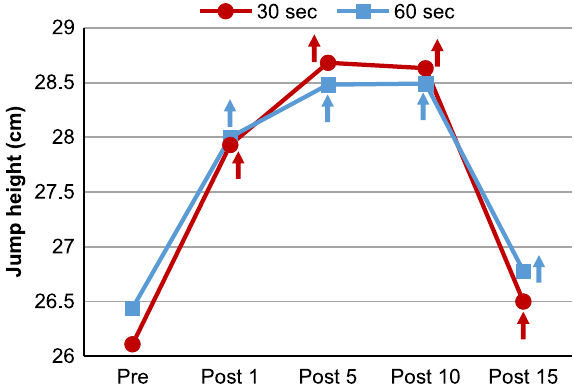
Figure 2. Squat jump performance for both protocols for the five assessments. Statistically significant differ- ences at the .05 level on post-test measurements with respect to the pre-test values for each protocol are de- noted by an